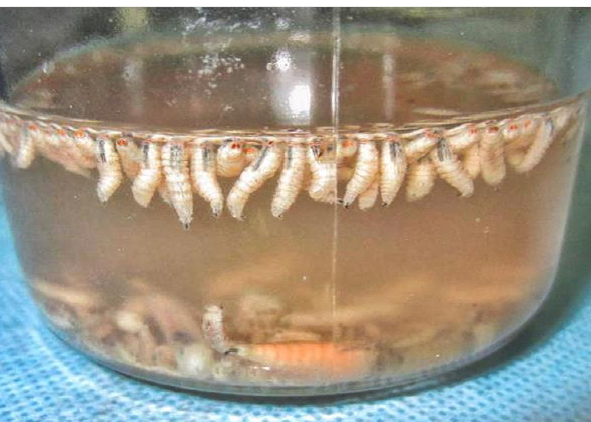
Fig. 2. Close view of the larval removal.